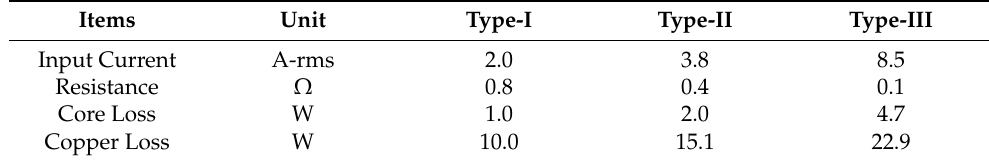
Table 6. Loss Data of the Designed Joint